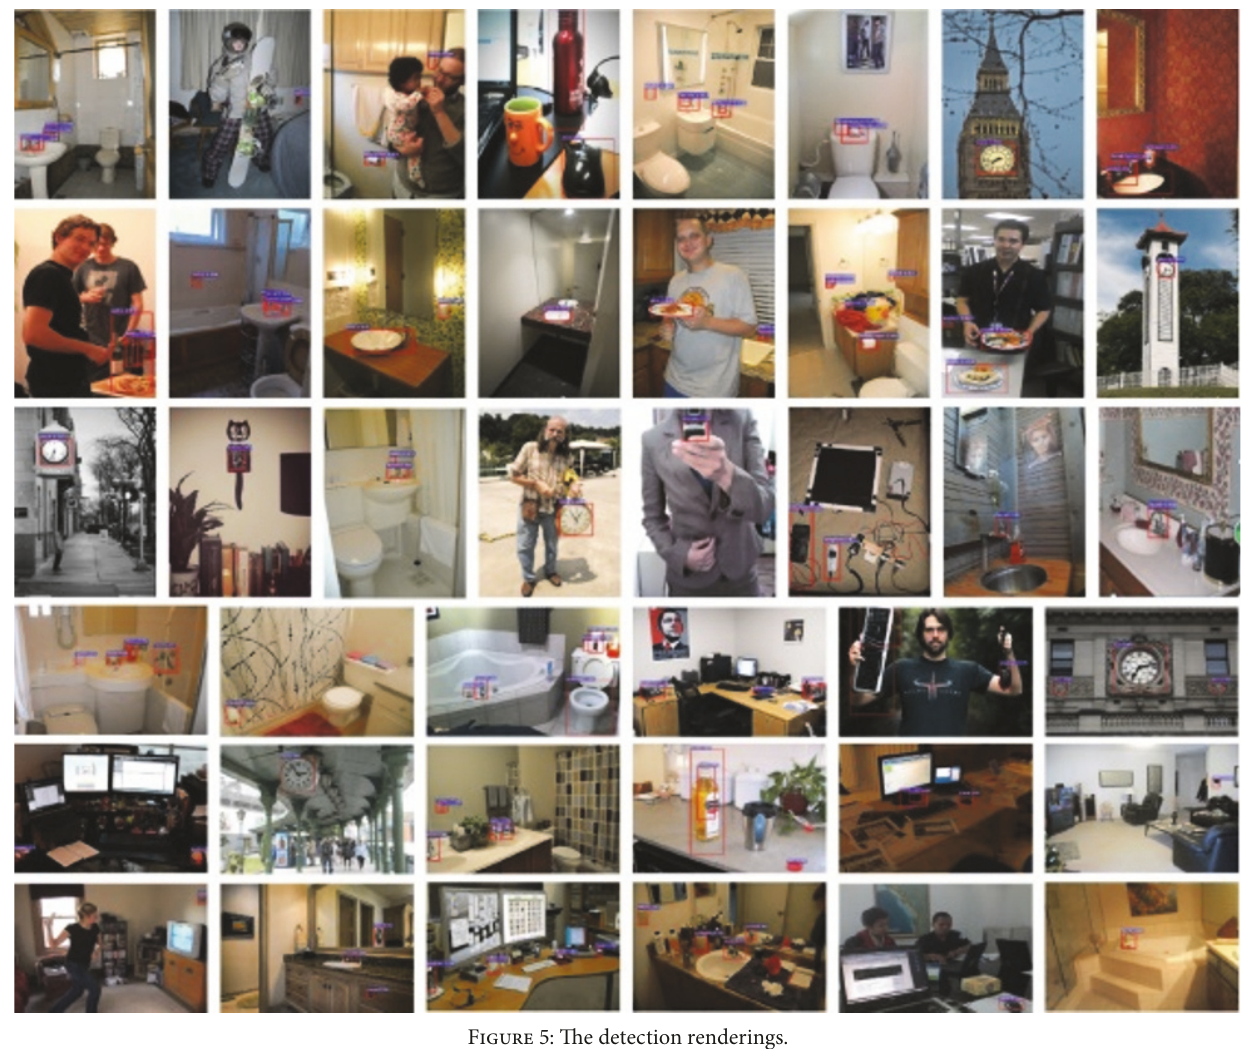
Figure 5: The detection renderings.